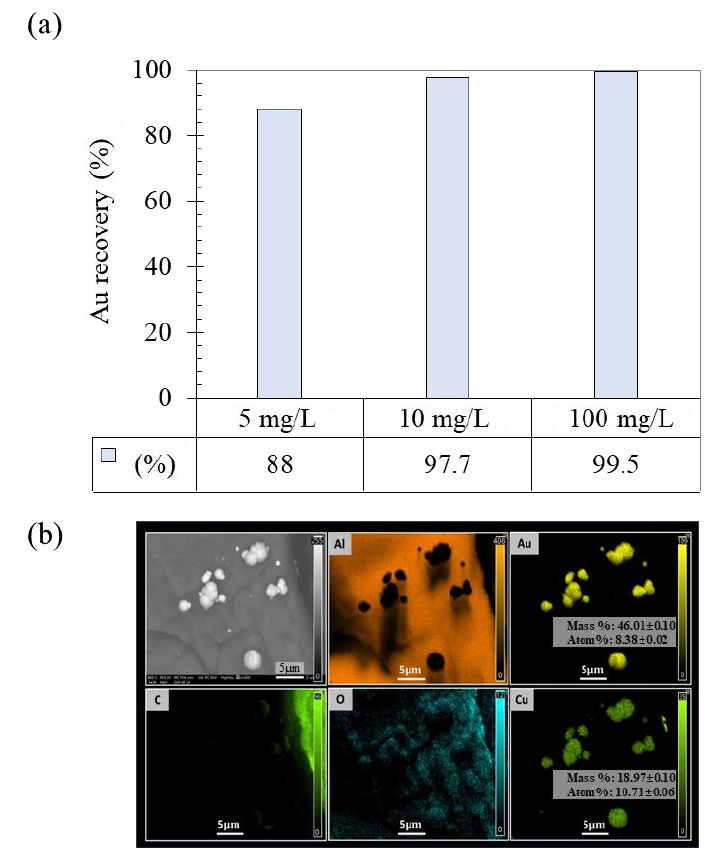
Figure 1. ( a ) Recovery of Au ions from ammonium thiosulfate solutions with varying initial concen- trations from 5 to 100 mg/L, and ( b ) SEM photomicrographs with corresponding elemental maps of the recovery residue at 10 mL/L of Au initial concentration.